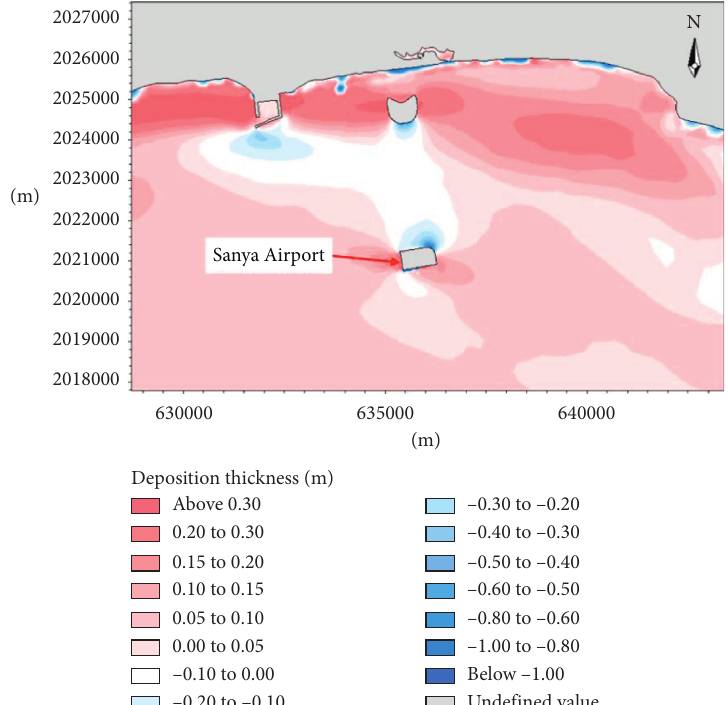
Figure 6: Annual seabed erosion and deposition